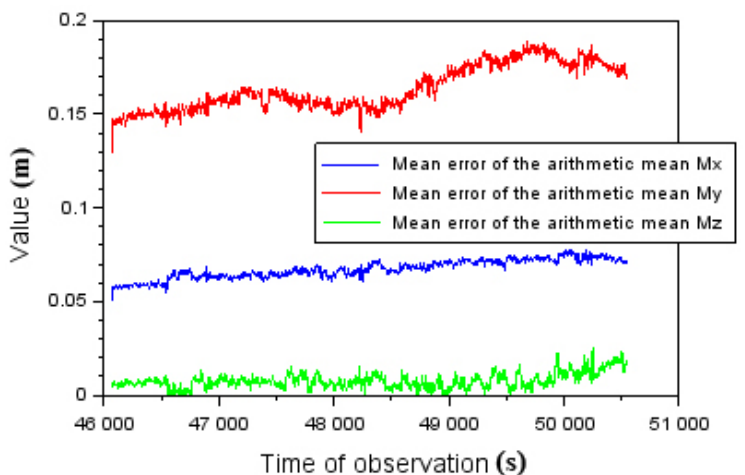
Figure 11. Mean errors of the arithmetic means (